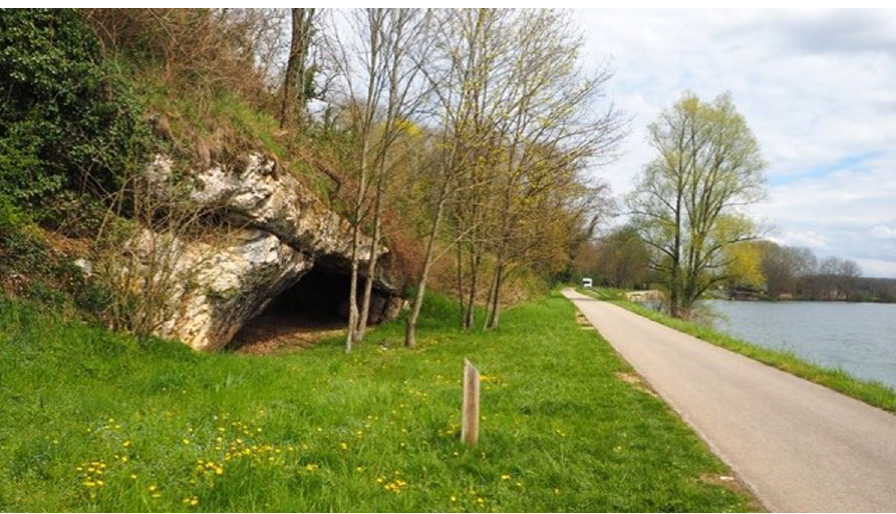
Figure 2: General view of Les Cabônes site ( Ranchot, Jura, France ) . The site is on the left, and the Doubs River is on the right. © C.